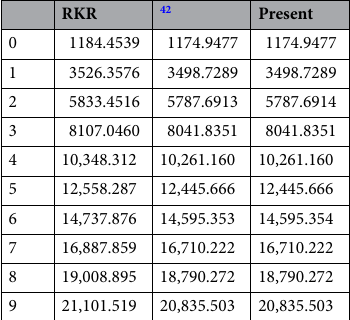
Table 6. Contains the calculated energy of vibrational levels (cm −1 ) and experimental values (cm −1 ) of nitrogen